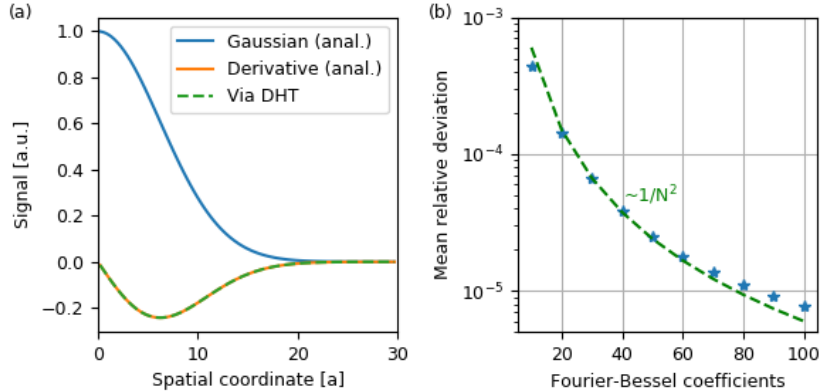
Figure 1. Validation of Equation (44) regarding the 0th-order DHT of the differential operator ρ − 1 ∂ / ∂ρ . ( a ): Sampled Gaussian and its analytical derivative as well as its derivative computed via the 0-th order DHT and the discussed transformation rule of the ρ − 1 ∂ / ∂ρ operator. ( b ): Mean relative deviation of the derivative computed via the 0-th order DHT with respect to its analytical counterpart. The dashed 1/ N 2 trend line is not fitted but only a guide to the